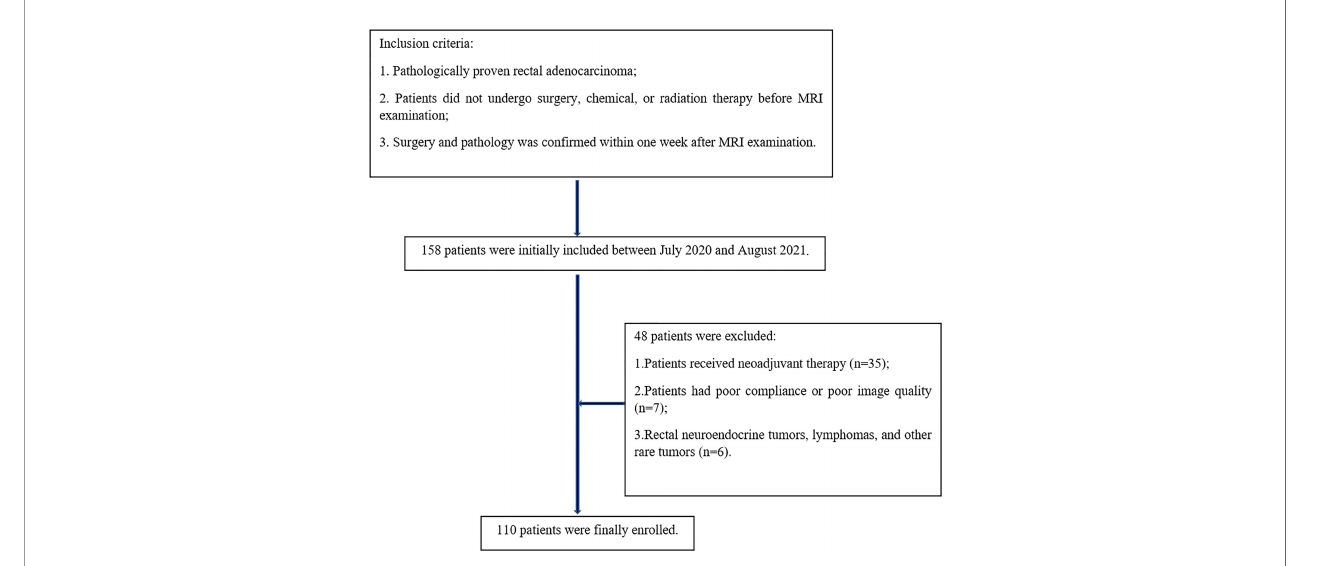
FIGURE 1 | Flowchart of patient